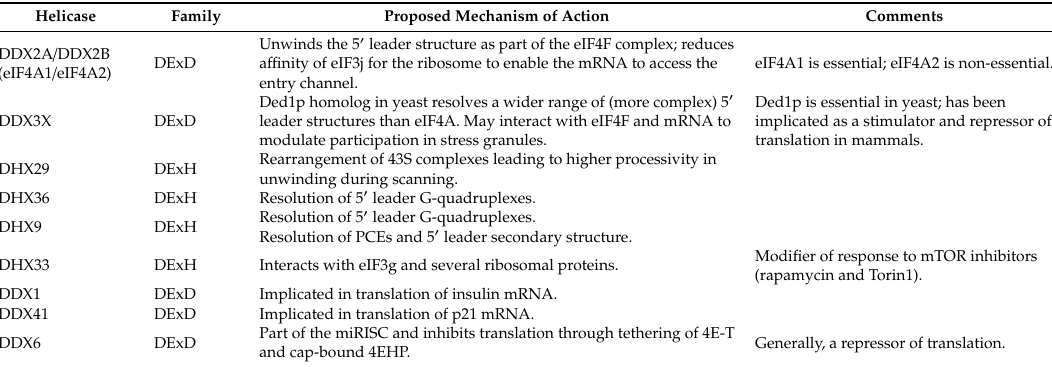
Table 1. RNA Helicases Implicated in Translational